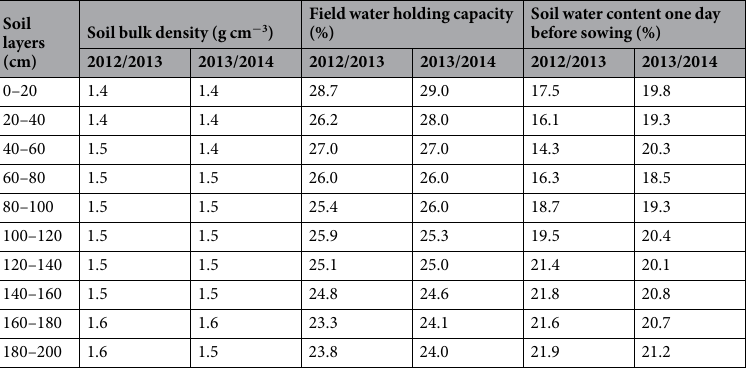
Soil water content one day before sowing (%)